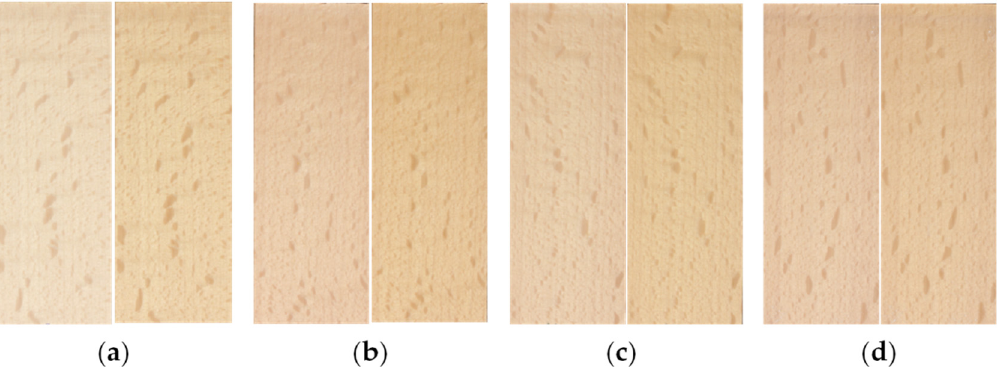
Figure 11. Visual appearance of coated and uncoated samples, before and after 170 h of UV irradiation: ( a ) control beech wood; ( b ) coated at v = 40 mm/s, Q air = 17 L/min, 1 pass; ( c ) coated at v = 30 mm/s, Q air = 17 L/min, 1 pass; ( d ) coated at v = 30 mm/s, Q air = 17 L/min, 3 passes. Table 3. Differences in color measurements before and after 170 h exposure to UV radiation.